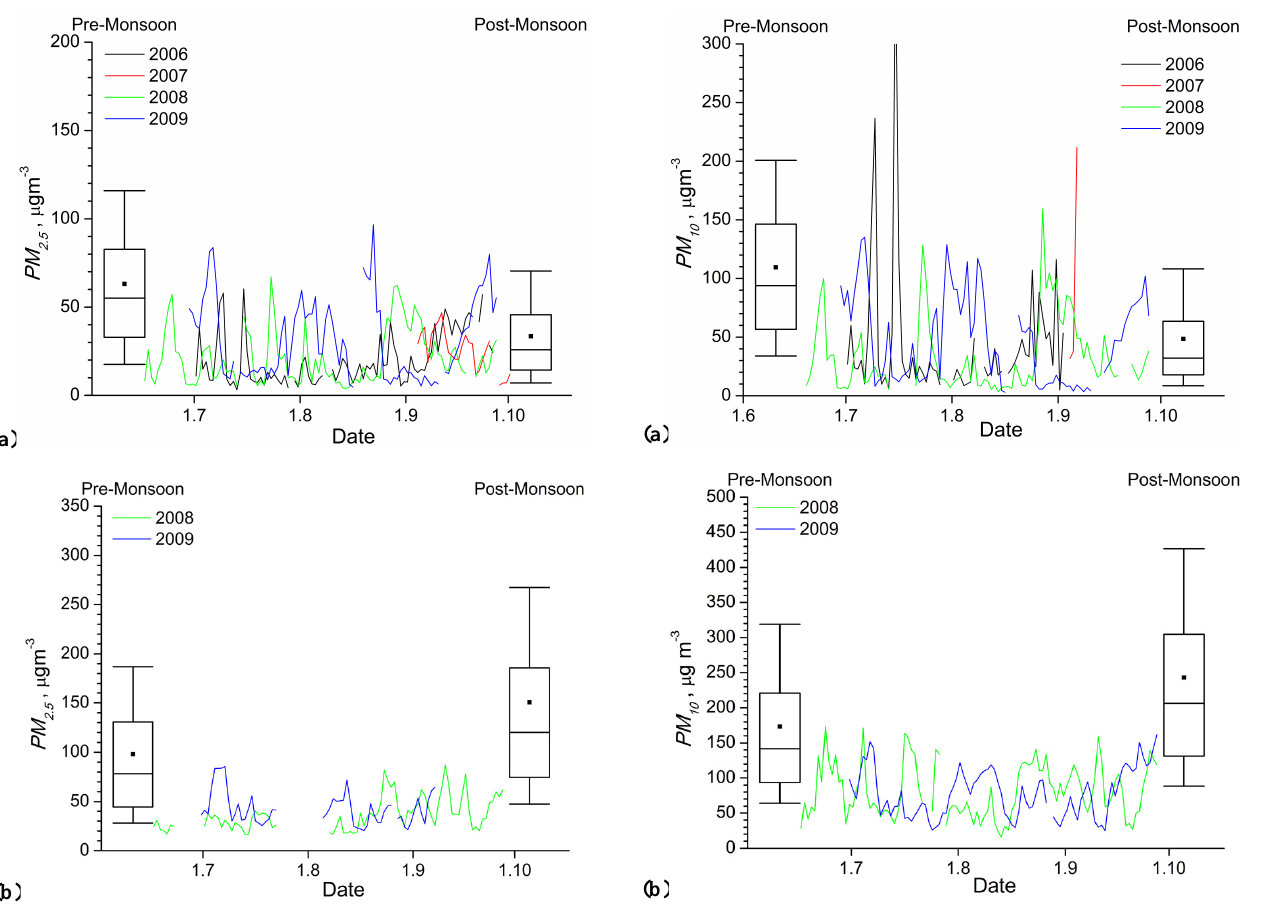
Fig. 7. PM 2 . 5 mass. (a) Mukteshwar (b) Gual Pahari. Lines are 24h running averages from the monsoon season, box plots denote the pre- and post-monsoon seasonal values of 10%-ile, 25%-ile, median (line), average (dot), 75%-ile, and 90%-ile. Concentrations are in STP conditions.